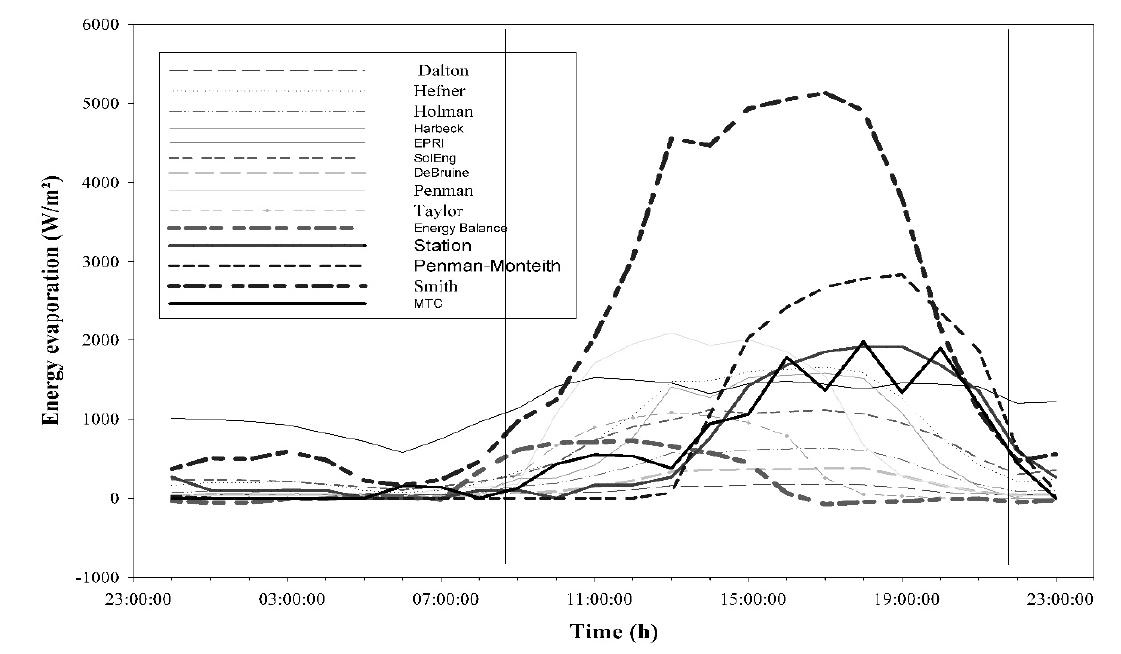
Figure 10. Evaporation rate on 2 August 2018 by different methods from Thomas Pond.